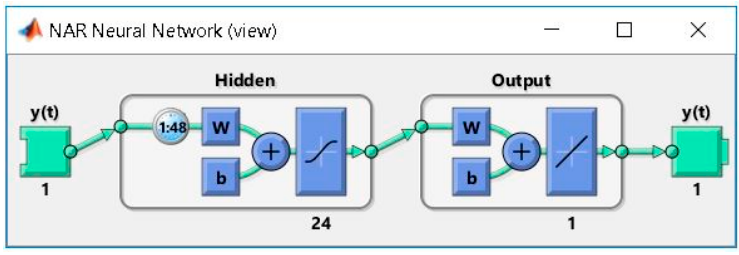
Figure 4. The ANN_NAR_BR’s architecture.